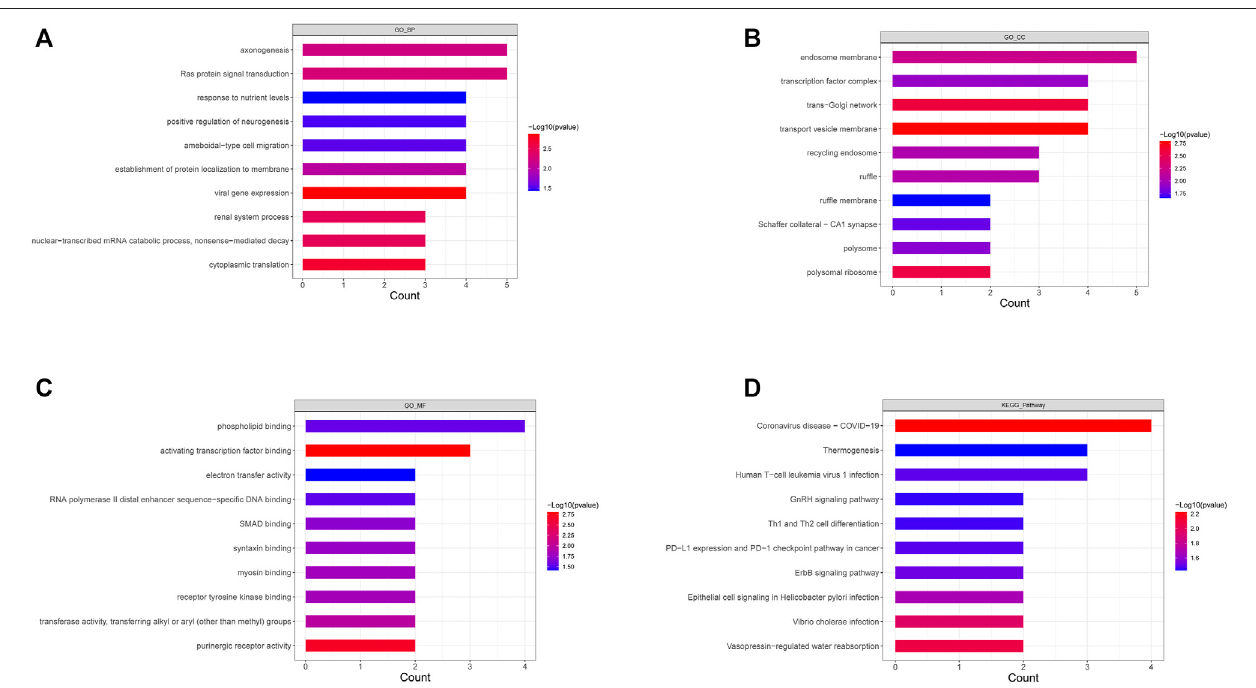
FIGURE2| GoannotationanKEGGenrichmentanalysisofDEGs. (A – C) Thetop10termsofBP (A) ,CC (B), andMF (C) ofGOannotationwereenrichedbyDEGs. (D) The top 10 KEGG pathways enriched by DEGs.